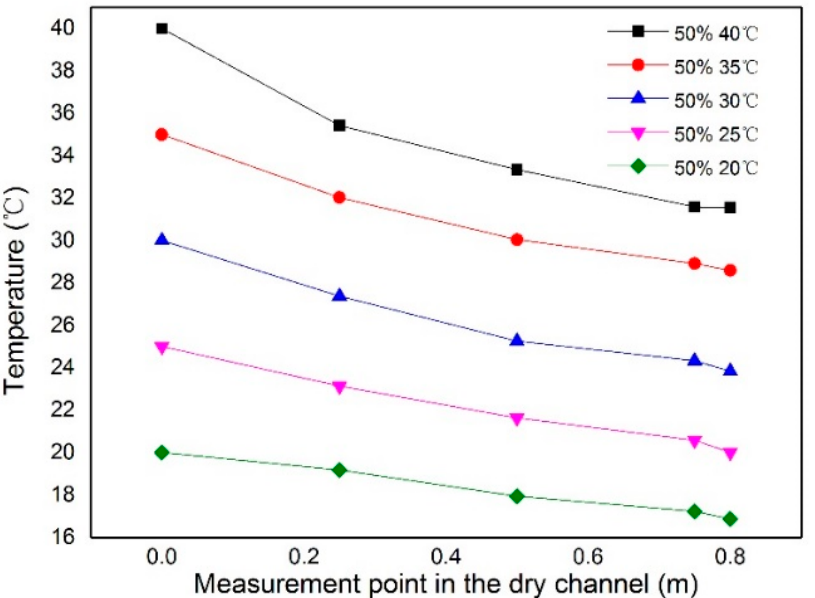
Figure 12. Temperature tendency in the channel under different humidity conditions.